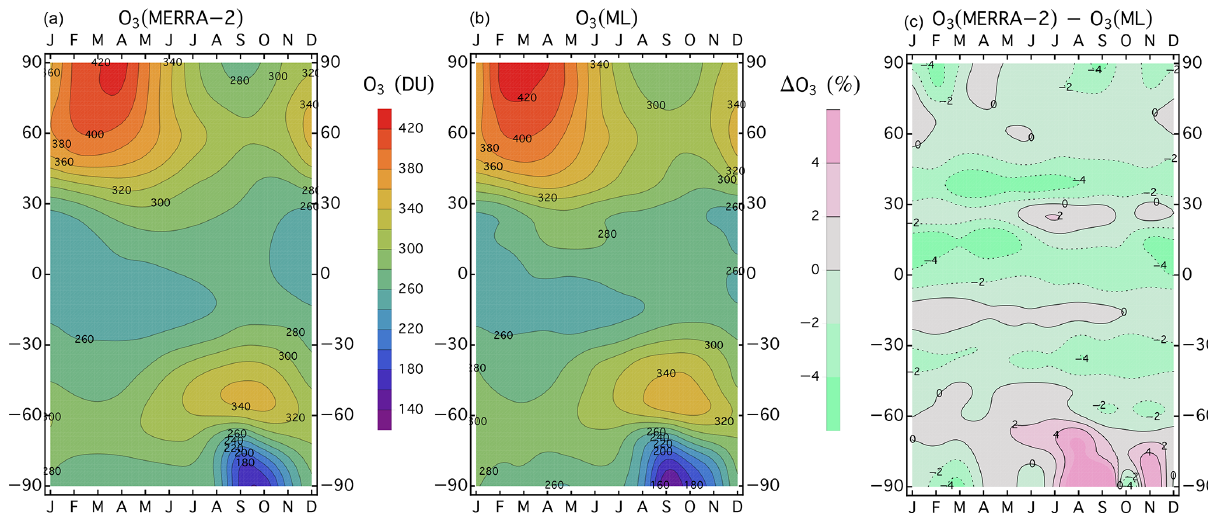
Figure 15. Comparison of monthly zonal mean total column O 3 from the daytime M2TCO3 (a) and the ML (b) climatologies and their relative differences (c) . Both climatologies capture the strong annual cycle of total O 3 , which exhibits a maximum in late winter–early spring in the NH and a minimum in late summer–early fall in the